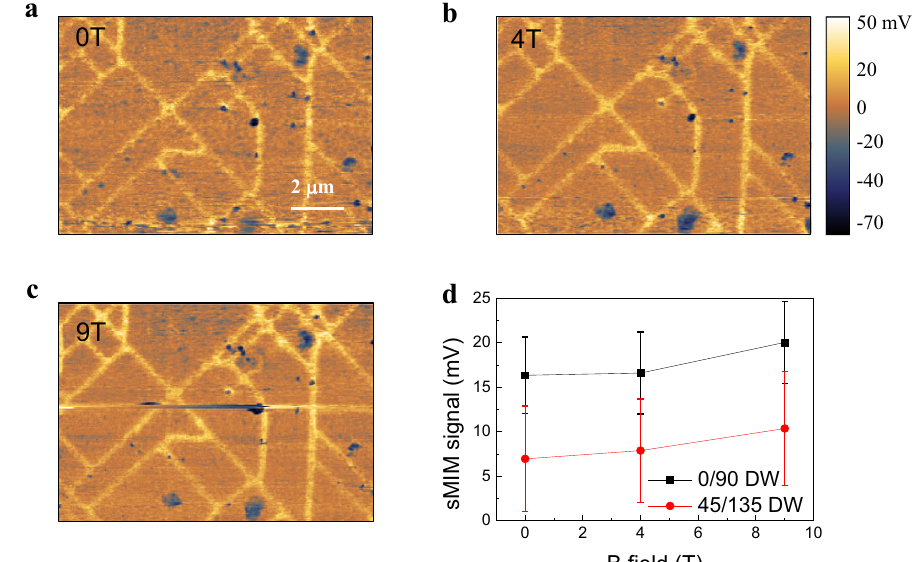
Fig.3|Scanningmicrowaveimpedancemicroscopy(sMIM)characterizationof nanoscale network of electronic phase separated domain. a – c sMIM images taken at 2K under different magnetic fi elds. Ferromagnetic metallic state with